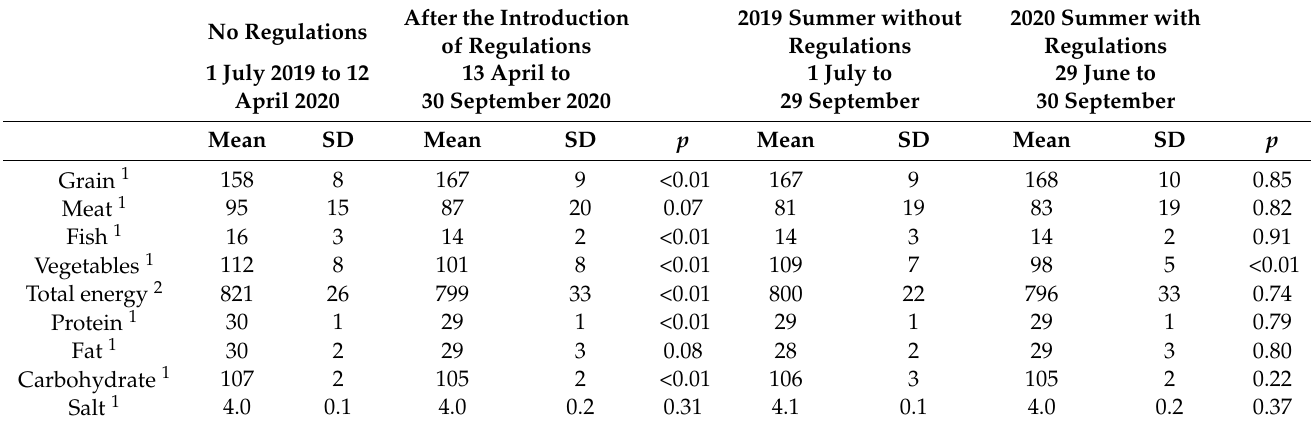
Table 1. Estimated mean food, total energy, and nutrient intake pre-pandemic and after the introduction of regulations. Pandemic regulations in the workplace cafeteria were implemented on 10 April 2020. p -values were obtained by the Student’s t -test.